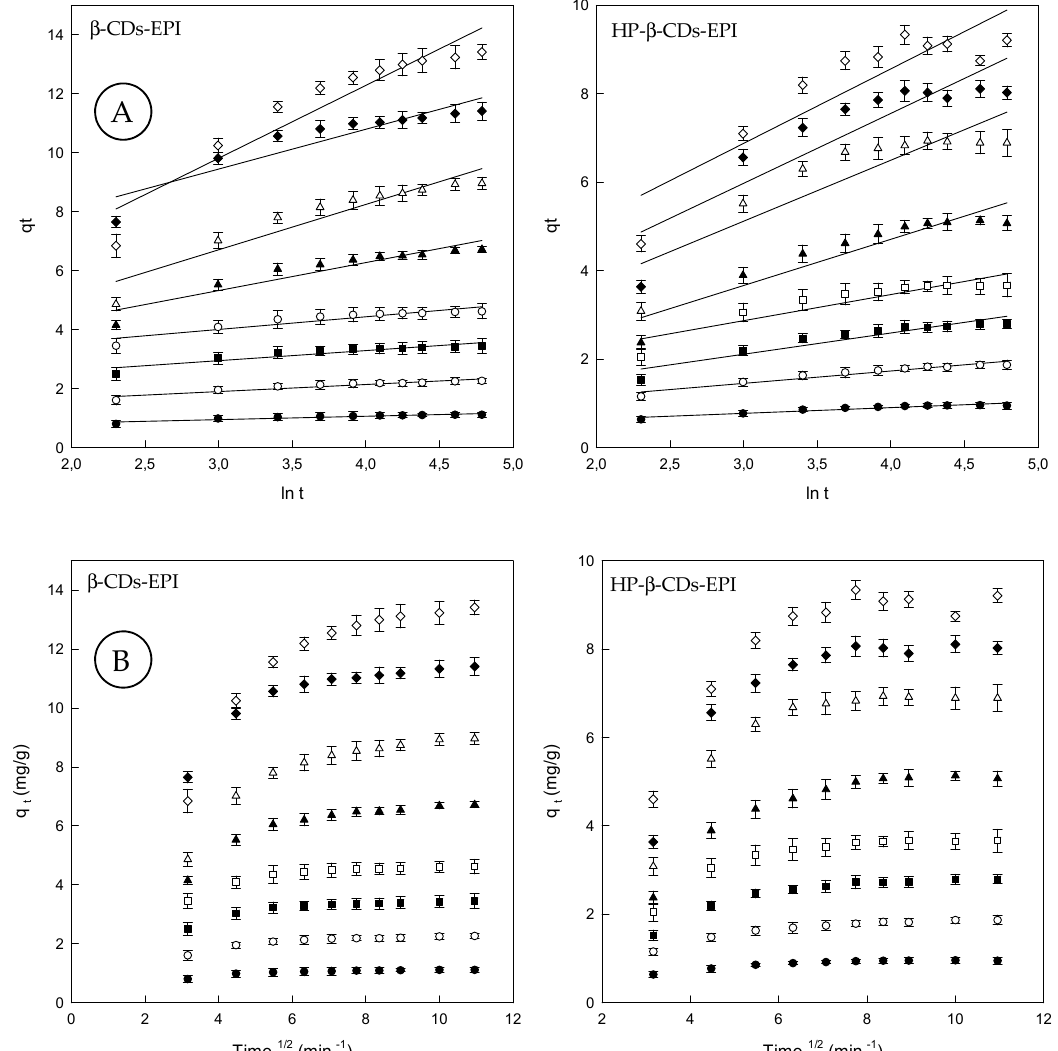
Figure 3. ( A ) Elovich model plots for the Direct Red 83:1 adsorption onto β -CDs-EPI and HP- β -CDs-EPI polymers. ( B ) Intraparticle diffusion model plots for the Direct Red 83:1 adsorption onto β -CDs-EPI and HP- β -CDs-EPI polymers at different dye concentrations (25 mg/L ( ● ), 50 mg/L ( ○ ), 75 mg/L ( ■ ), 100 mg/L ( □ ), 150 mg/L ( ▲ ), 200 mg/L ( Δ ), 250 mg/L ( ♦ ) and 300 mg/L ( ⟡ )).